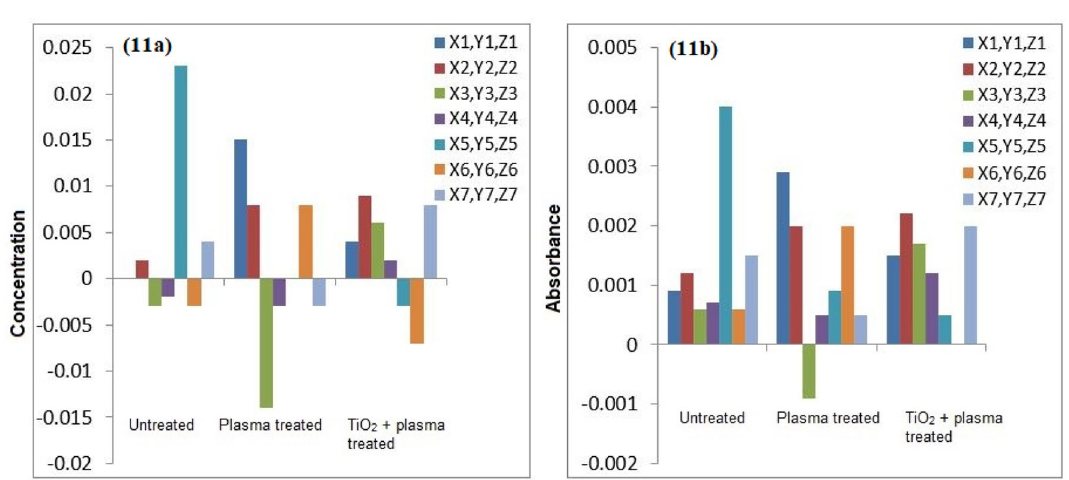
Figure 10. ( a ) Comparison of Ni concentration (mg/l), ( b ) Comparison of Ni absorbance (mg/l).